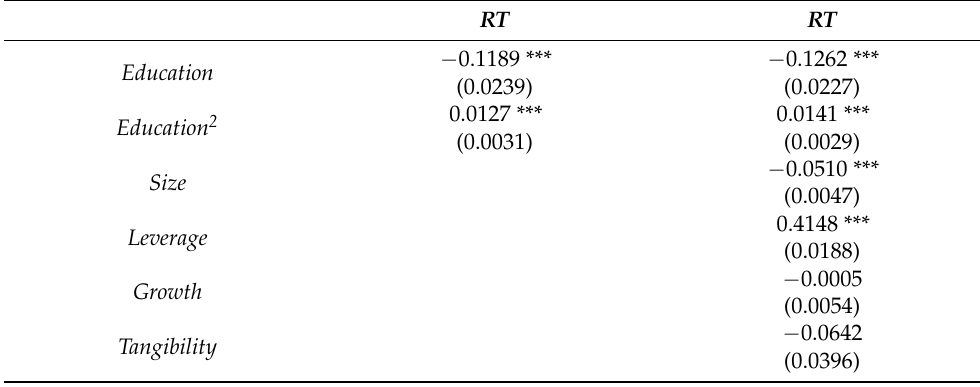
Table 4. Nonlinear quadratic